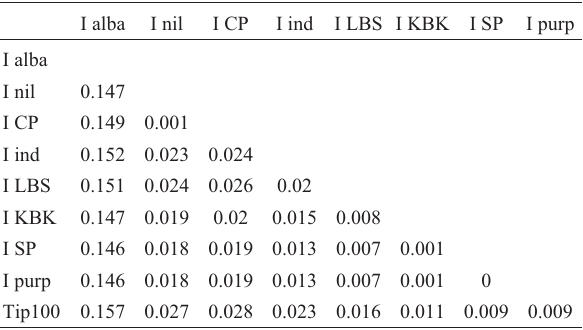
Table 2 - Nucleotide divergence analysis of Tip100